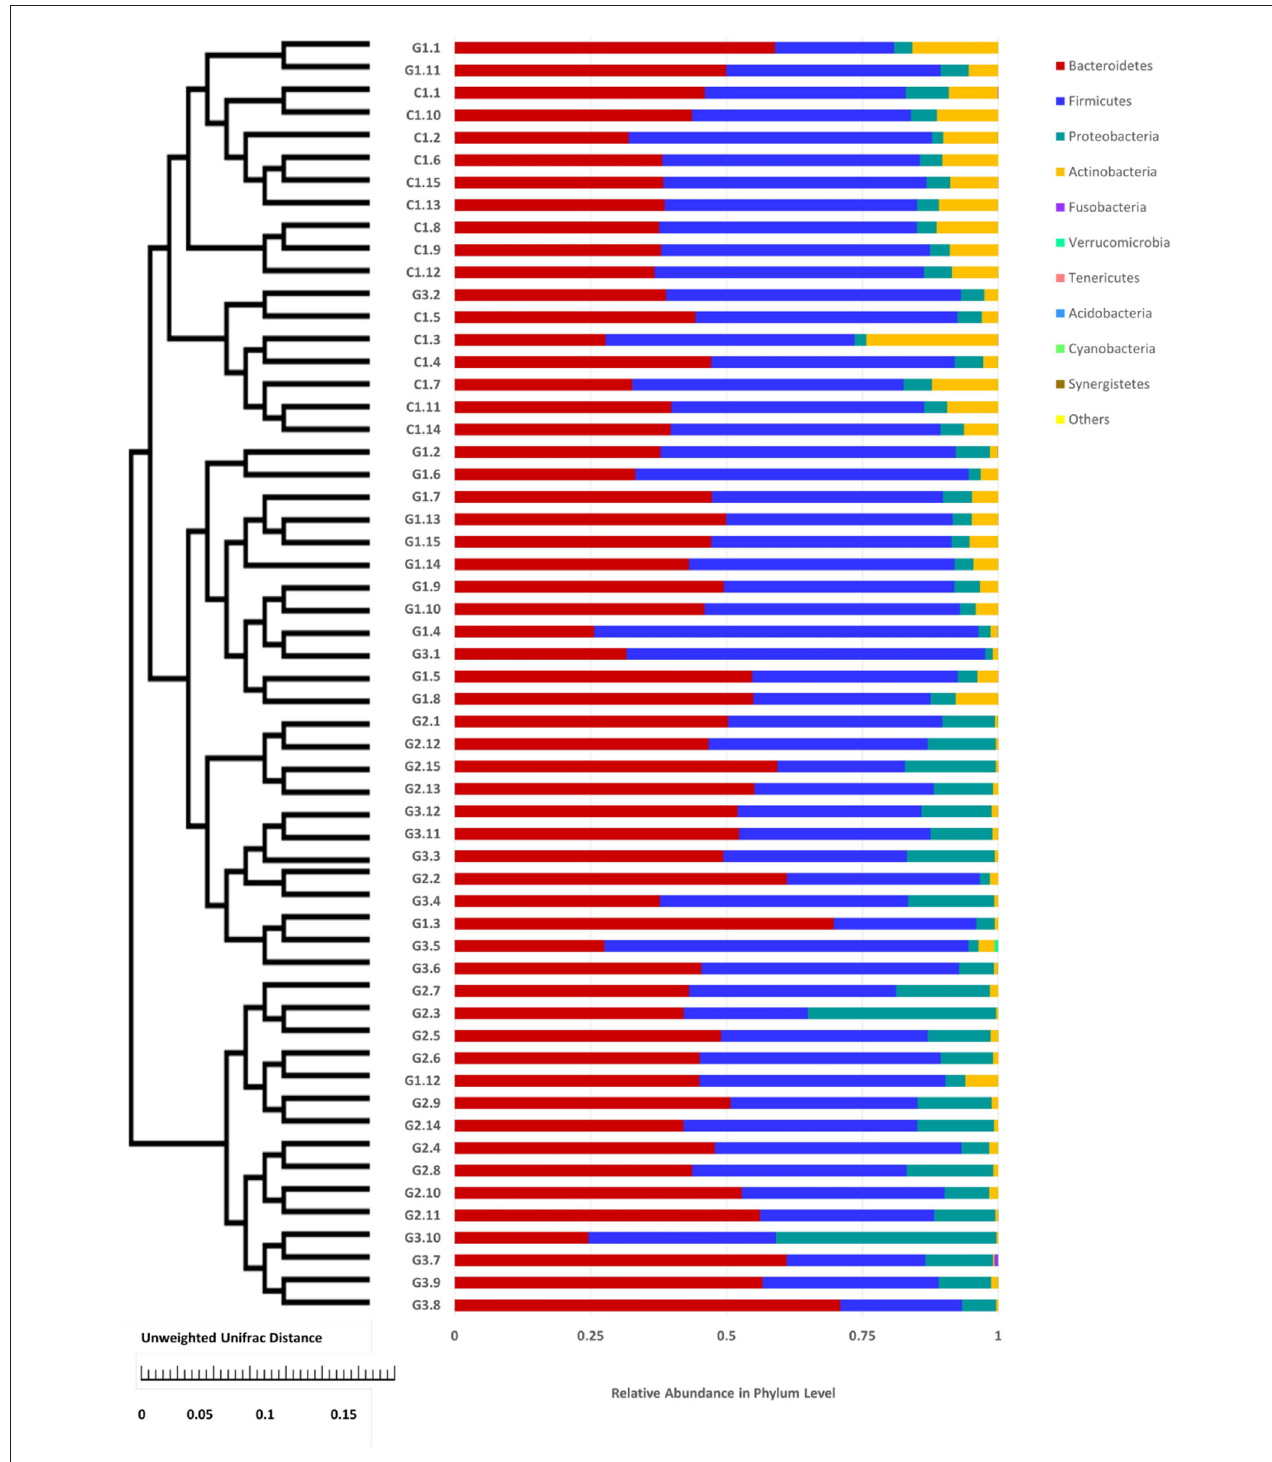
FIGURE 4 | Cluster of relative abundance of the intestinal flora at the phylum level in each sample. The left side is the UPGMA cluster tree structure, on the right is the sample at the phylum level of the relative abundance of specie distribution map.